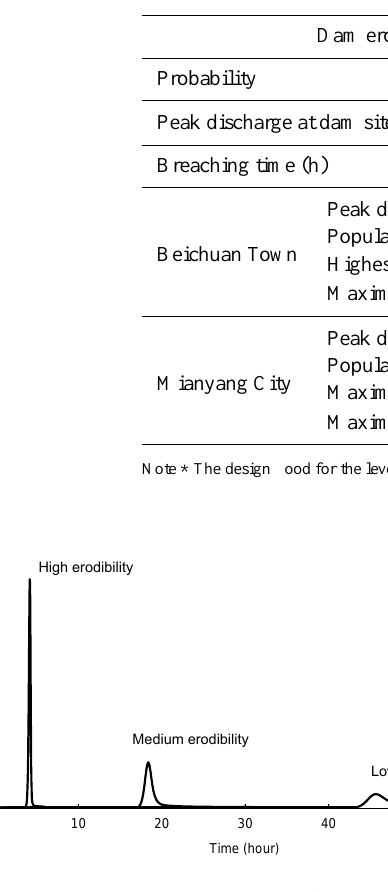
Fig. 9. Outflow rates in the three scenarios of stage 1